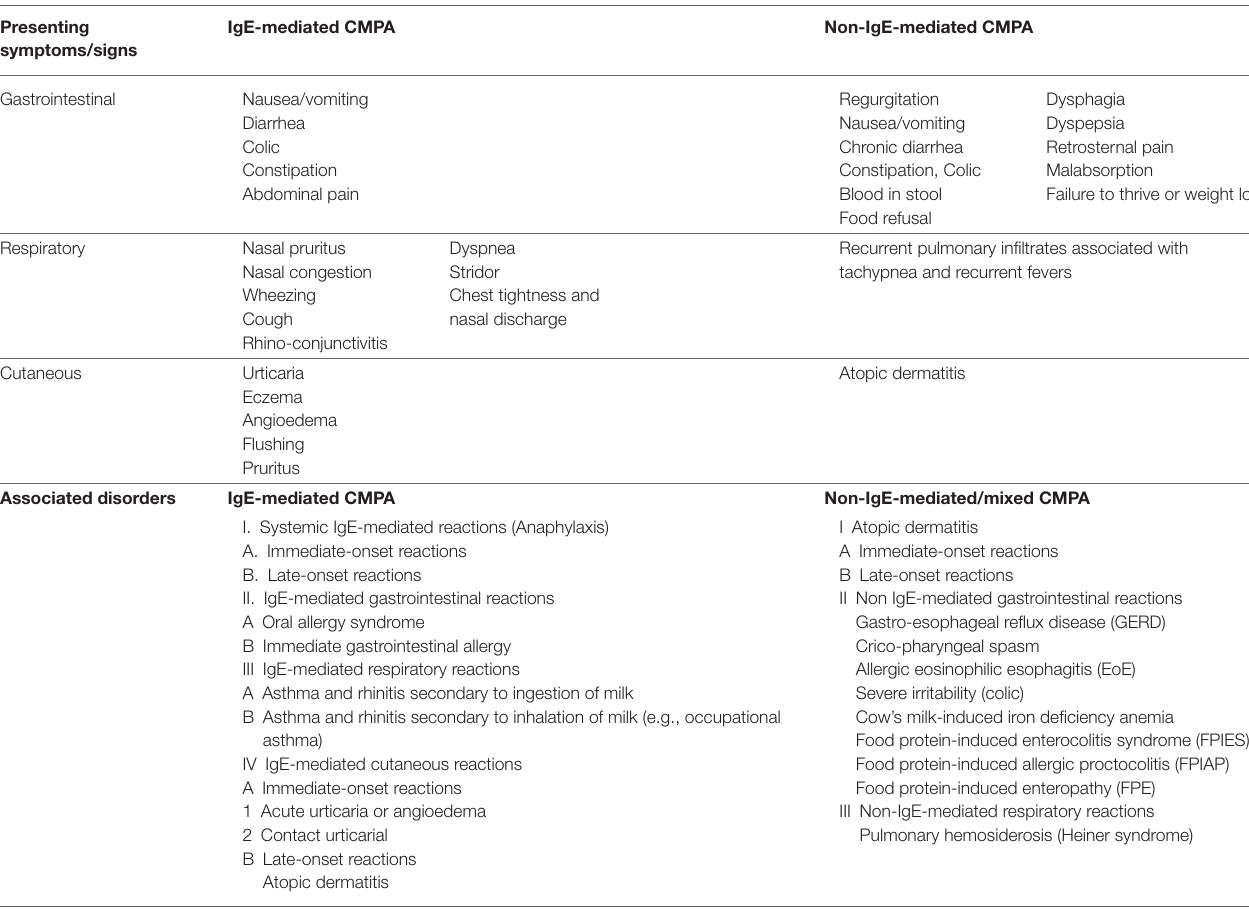
TABLE 1 | Clinical presentation of CMPA with respect to type of immune reaction (14, 18,